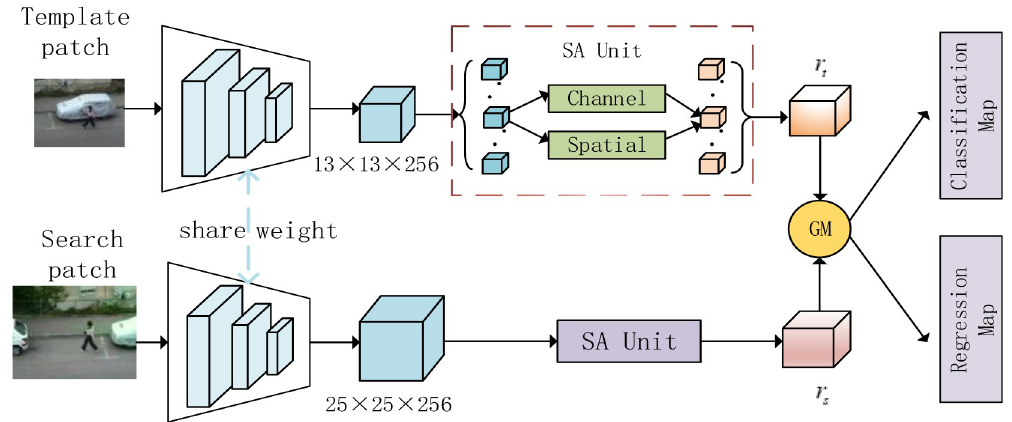
Fig 1. Architecture of the proposed Shuffle and Graph Attention